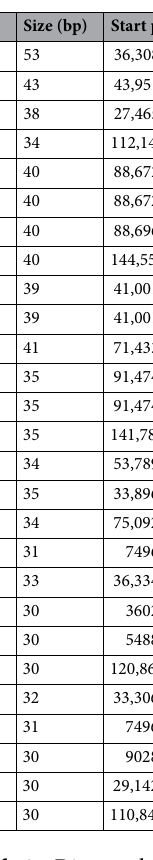
Ka/Ks value was 0.4839 (Fig. 6), indicating that at the whole cp protein level, Lilium species were subjected to a purifying selection. Phylogenetic analysis. Both analyses, which used the complete chloroplast genome (CCGs) and protein coding genes (CDSs), divided 47 Lilium species into two main groups. Although the members of both main groups were the same in both topologies, there were slight differences between them (Figs. 7, S4). Because of the high synteny among Lilium cp genomes, this study concentrated on phylogenetic analysis employing whole cp genome sequences to inspect relationships across the 47 Lilium species. Maximum likelihood was employed with two species serving as outgroups. According to the topology, the majority of nodes were highly supported. In all, 34 of the 45 nodes acquired a maximally supported (value ≥ 99%) value bootstrap. According to the CCG topology, the 47 Lilium species were divided into two main groups consisting of 11 clades (Fig. 7). Group 1: included 17 species, which were placed in four clades and four self-sufficient lineages. Clade I con- sisted of six Sinomartagon species including L. callosum , L. amabile , L. cernuum , L. lancifolium , L. pensylvanicum , and L. primulinum . Clade II is composed of two Martagon species (L . tsingtauense and L. hansonii ). Clade III consisted of two Leucolirion ( L. formosanum and L. longiflorum ), and L. brownie belong to Archelirion. L. can- didum of Liriotypus and L. ledebourii established a monophyletic clade IV. L. davidii was the sister of Claude II. L. martagon , L. leichtlini , and L. bulbiferum had more distant connections with claude I Sinomartagons (Fig. 7). Group 2: included 30 species, which were placed in seven clades and three self-sufficient lineages. Clade V was composed of four Sinomartagon species including L. bakerianum , L. taliense , L. primulinum , and L. nepa- lense . Clade VI consisted of two Sinomartagon ( L. henricii and L. souliei ), and three species ( L. pardanthinum , L. gongshanense , and L. meleagrinum ), which have recently been transferred from the genus Nemacaris to the genus Lilium . L. speciosum , L. japonicum , and L. distichum formed calde VII. Five species of Leucolirion including L. regale , L. leucanthum , L. sulphureum , L. sargentiae , and L. henryi , created clade VIII. Clade IX accommodated L. duchartrei and L. lankongense . Three species of Lofoforum ( L. fargesii , L. lophophorum , and L. matangense ), along with L. nanum and L. xanthellum , were included in clade X. Three species ( L. superbum and L. washingtonianum , and L. pardalinum ) belonging to Pseudolirium formed clade XI. L. amoenum , L. rosthornii , and L. philadelphicum were sisters to the clade V, clade VIII, and clade X, respectively (Fig. 7).